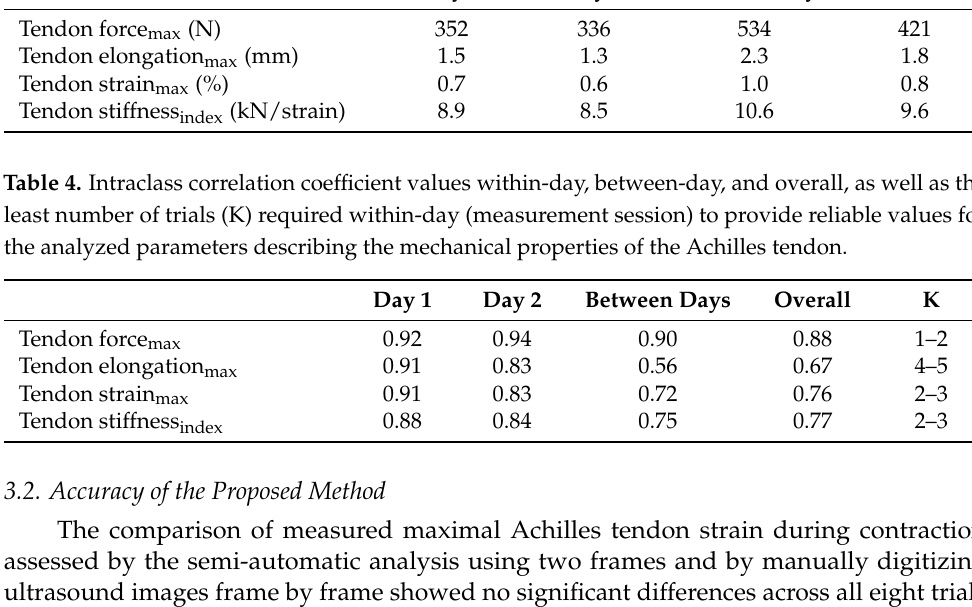
Table 3. Root mean square differences within-day, between-day, and overall, for the analyzed parameters describing Achilles tendon mechanical properties. Day 1 Day 2 Between Days Overall Tendon force max (N) 352 336 534 421